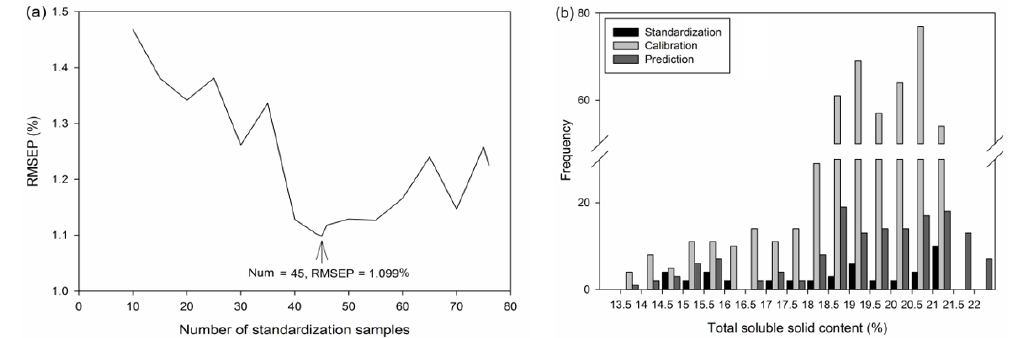
Figure 4. The plot of the number of standardization verses the root mean squares error of same prediction set based on least-squares support vector machine regression ( a ) and the distributions of total soluble solid contents in the optimal linear interpolation-PDS model ( b ).